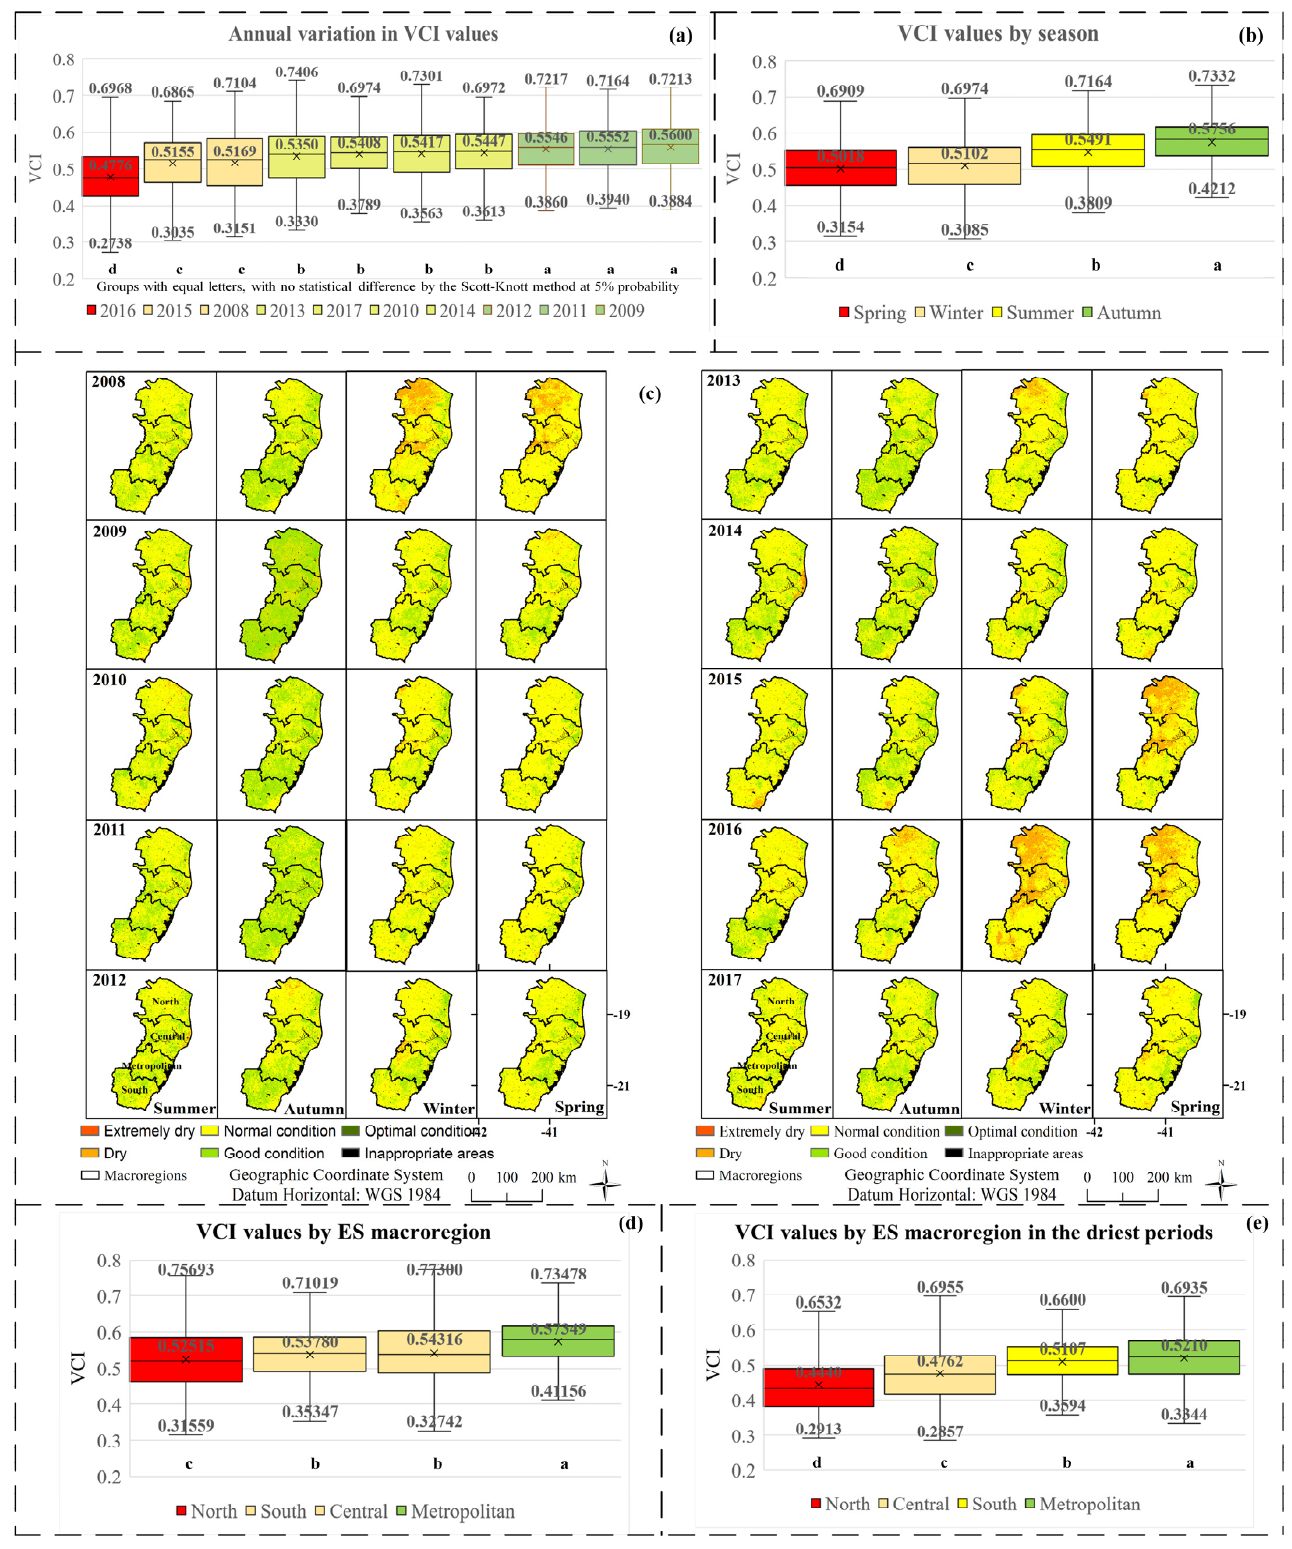
Figure 3. Comparison of the annual mean VCI values for Espírito Santo ( a ); comparison of the mean VCI values by season ( b ); comparison of the spatialization of VCI across five drought classes for the State of Espírito Santo over four seasons ( c ); comparison of the average VCI values by Espírito Santo’s planning macroregions ( d ); comparison of the mean VCI values by Espírito Santo’s macrore- gions, by contemplating 2008, 2013, 2015, and 2016 during winter and spring ( e ).